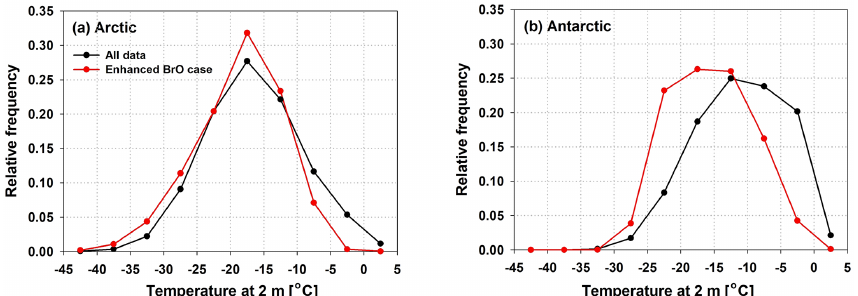
Figure 6. Frequency distribution of surface air temperature for all data (black line) and the enhanced BrO case (red line) in (a) the Arctic and (b) Antarctic sea ice regions in spring (Arctic: March to April; Antarctic: September and